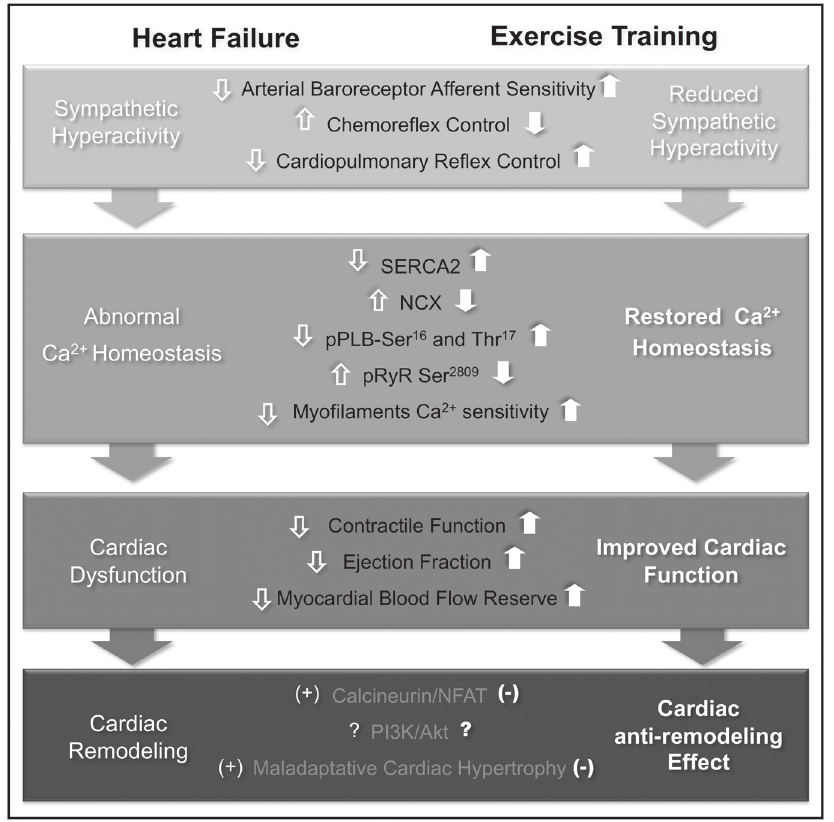
Figure 2. Effects of exercise training on cardiac function and remodeling. Note that sym- pathetic hyperactivity in heart failure is linked to altered afferent autonomic control by ar- terial baroreceptors, cardiopulmonary receptors and chemoreceptors. Additionally, cardiac dysfunction and remodeling in heart failure are associated with impaired Ca 2+ homeostasis by altered expression of Ca 2+ -handling proteins and myofilament Ca 2+ sensitivity, as well as activation of the calcineurin/NFAT signaling pathway. Interestingly, exercise training decreases sympathetic nerve activity and re-establishes Ca 2+ homeostasis, which ultimately contributes to improved cardiac function and anti-remodeling. SERCA2 = sarcoplasmic reticulum Ca 2+ AT- Pase; NCX = Na + /Ca 2+ exchanger; pPLB-Ser 16 and Thr 17 = phosphorylated phospholamban at both Ser 16 and Thr 17 residues; pRYR Ser 2809 = phosphorylated ryanodyne at the Ser 2809 residue; NFAT = nuclear factor of activated T-cells; PI3K = phosphatidylinositol 3-kinases; Akt = protein kinase